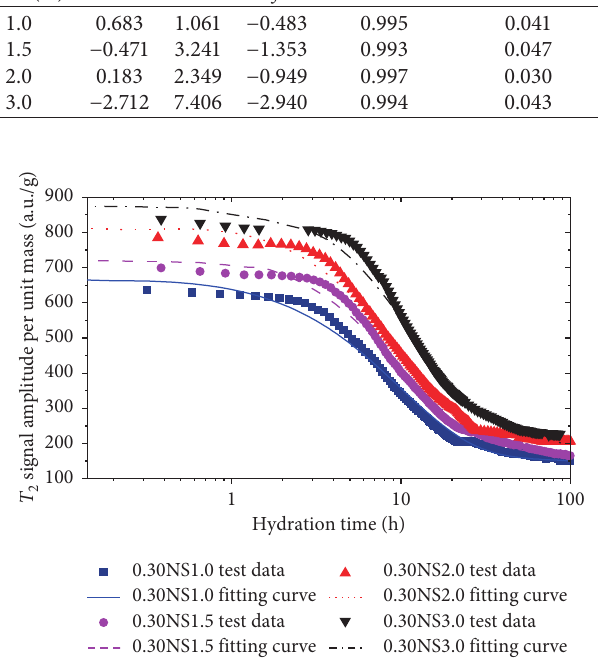
Figure 8: Experiment data and fitting results of NS cement pastes. Table 9: Fitting parameters and correlation of cement pastes with different SAP